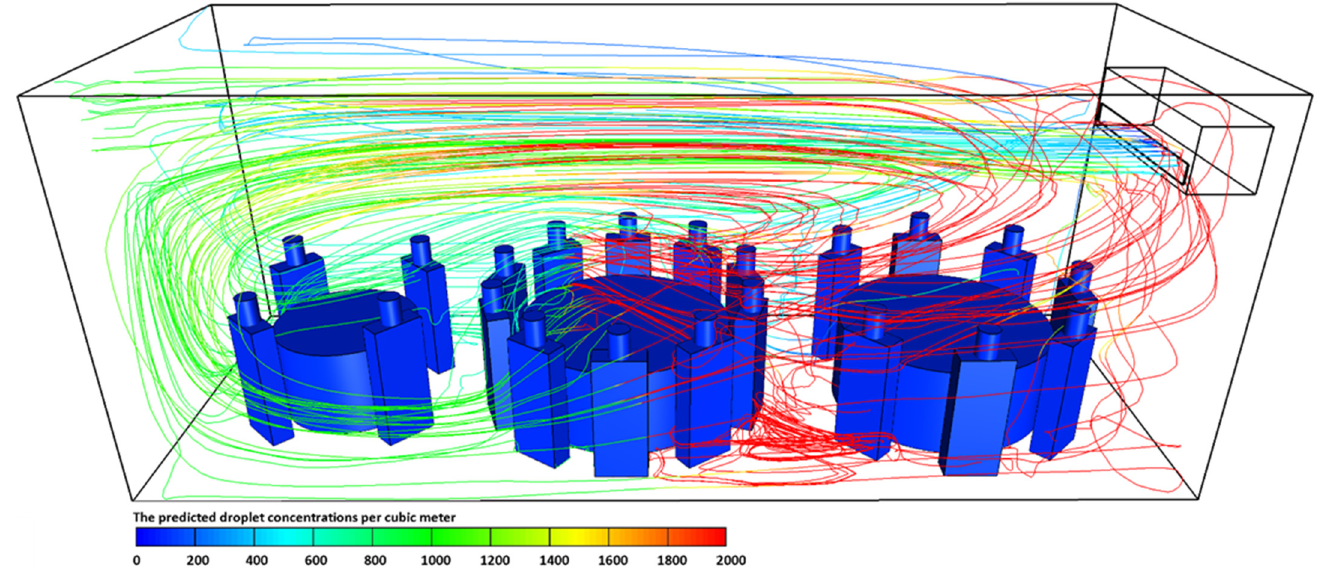
Figure 5. The predicted droplet concentrations per cubic meter exhaled from index case (T2C1) at t = 4500 s for case-1.